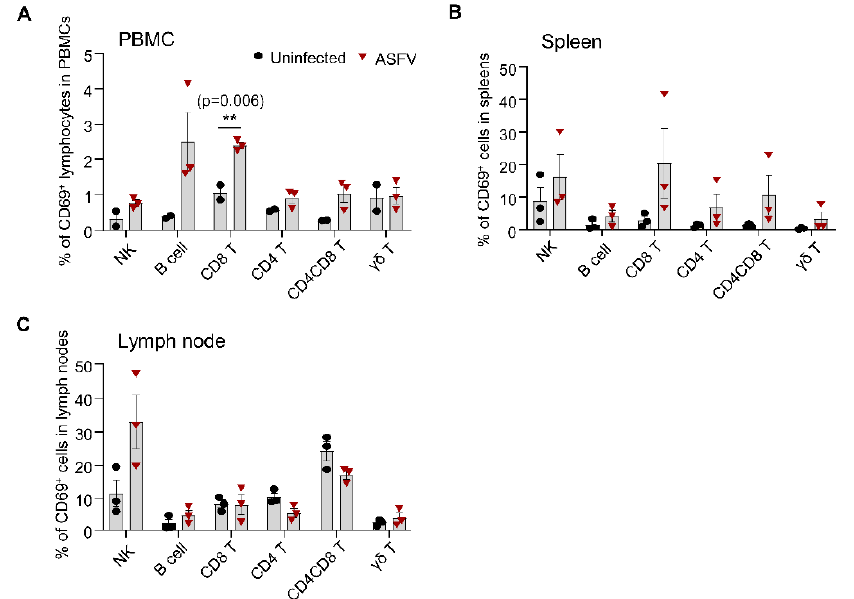
Figure 6. ASFV infection induces the early activation of different lymphocyte subsets in the blood and lymphoid organs of pigs. Healthy piglets were infected or not infected with the ASFV HLJ/18 strain by intramuscular injection. Peripheral blood, spleens, and submandibular lymph nodes were collected on day 5 after infection and single-cell suspensions were prepared for the detection of CD69 expression on different lymphocyte subsets, using flow cytometry. The percentages of CD69-positive NK cells, B cells, CD8, CD4, and CD4 + CD8 + T cells, as well as γδ T cells in the PBMCs ( A ), spleen ( B ), and submandibular lymph node cells ( C ) were compared between mock-infected and ASFV-infected pigs ( n = 3). Data shown are mean ± SEM. ns = no statistical significance. ** p < 0.01.